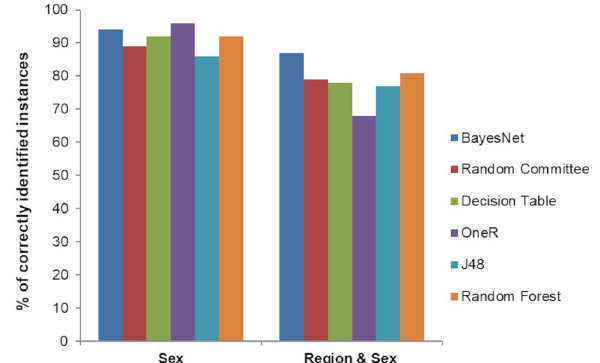
Figure 5. Top Machine Learning algorithms with the percentage of correctly classified instances of Painted Storks with Sex as classifier and Region & Sex as another